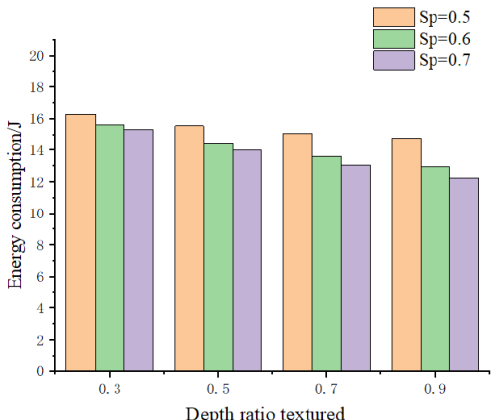
Figure 12. Energy consumption with different depth ratio textured under varying area ratio textured.